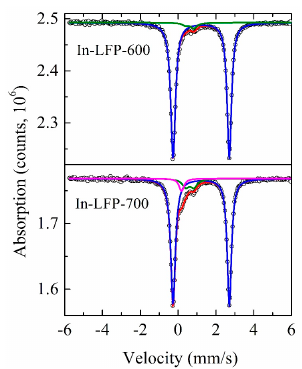
Figure 4. Mössbauer spectra of In-LFP-600 and In-LFP-700 samples measured at room temperature. Table 2. Room temperature Mossbauer parameters of In-doped LiFePO 4 /C samples annealed at 600 °C and 700